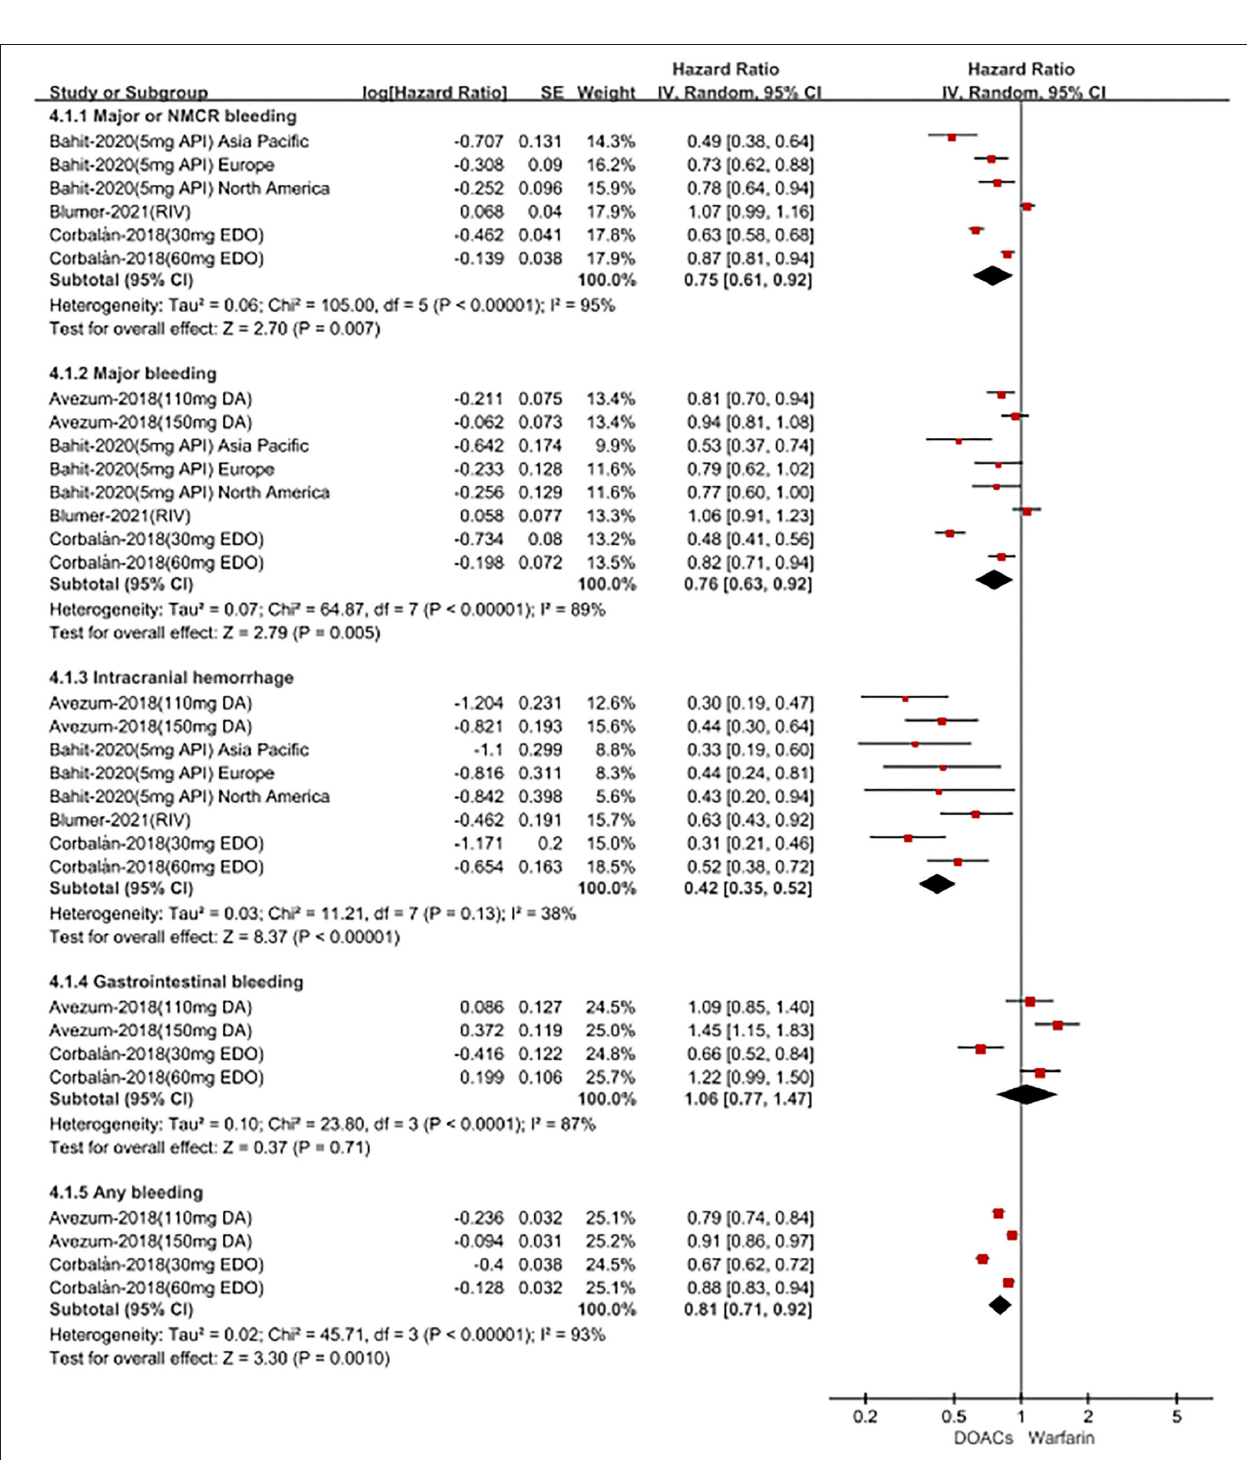
Frontiers in Cardiovascular Medicine |